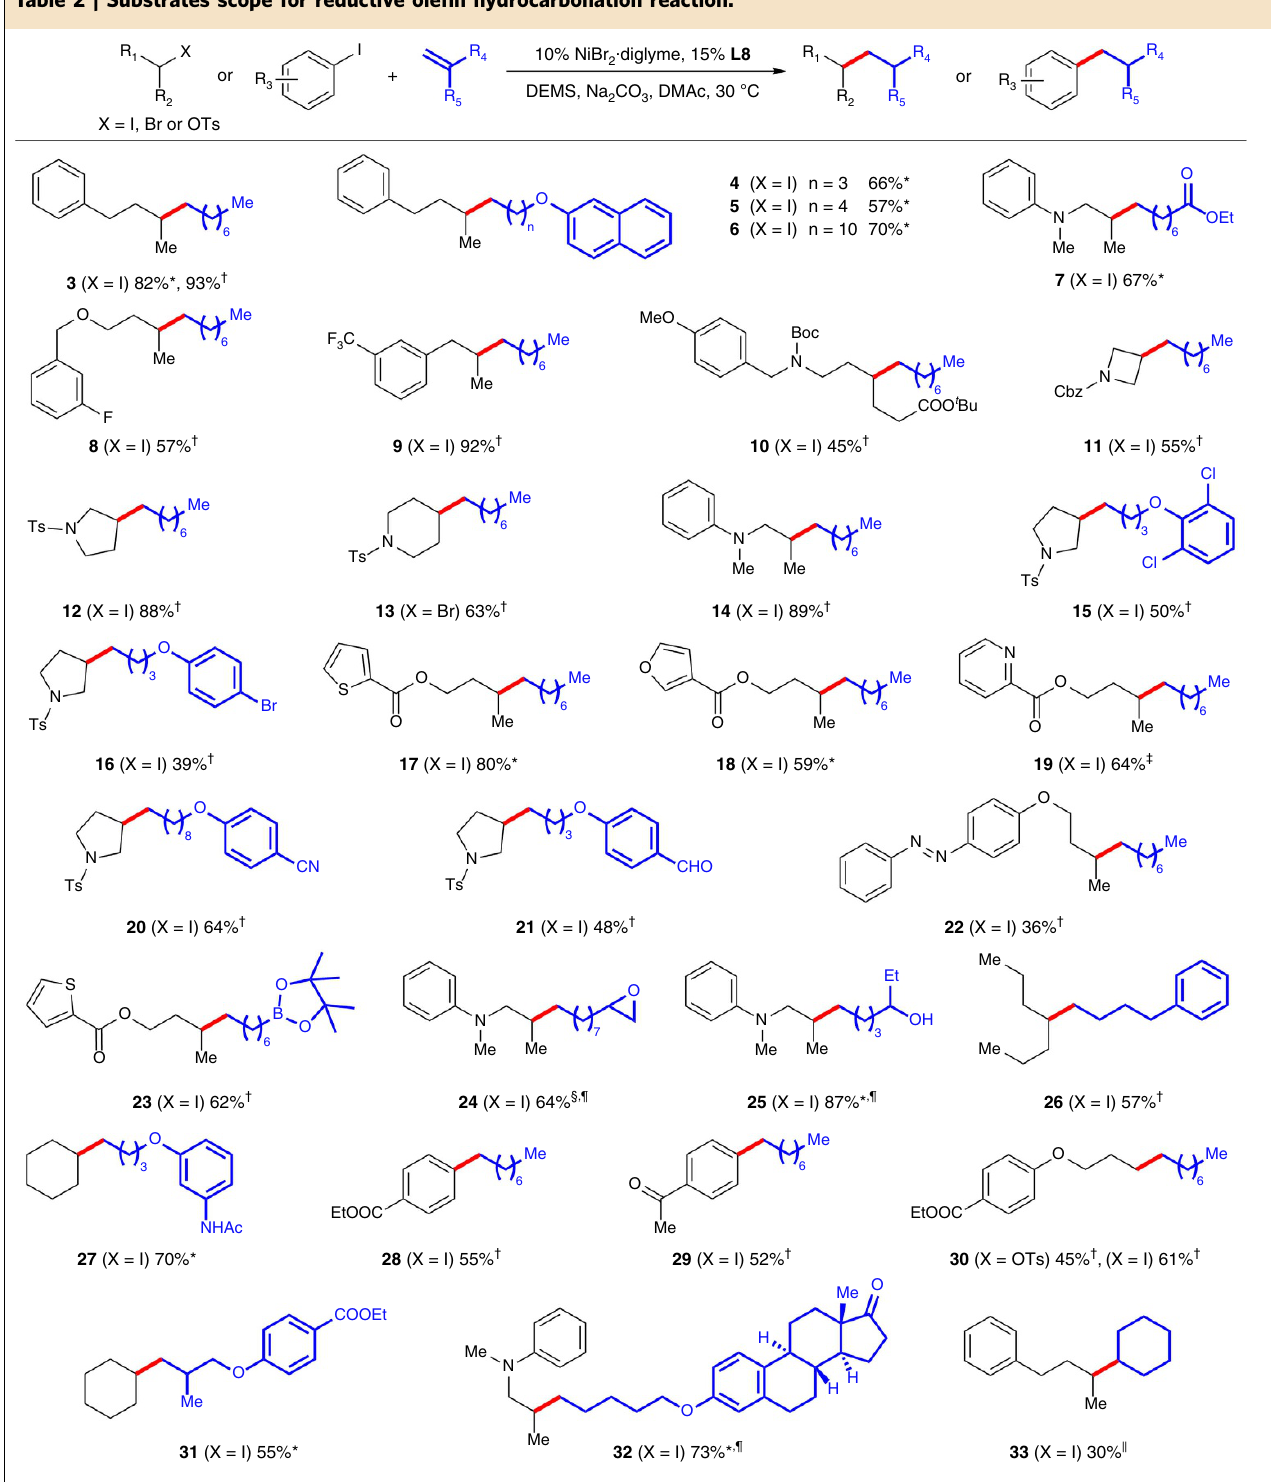
Table 2 | Substrates scope for reductive olefin hydrocarbonation reaction.